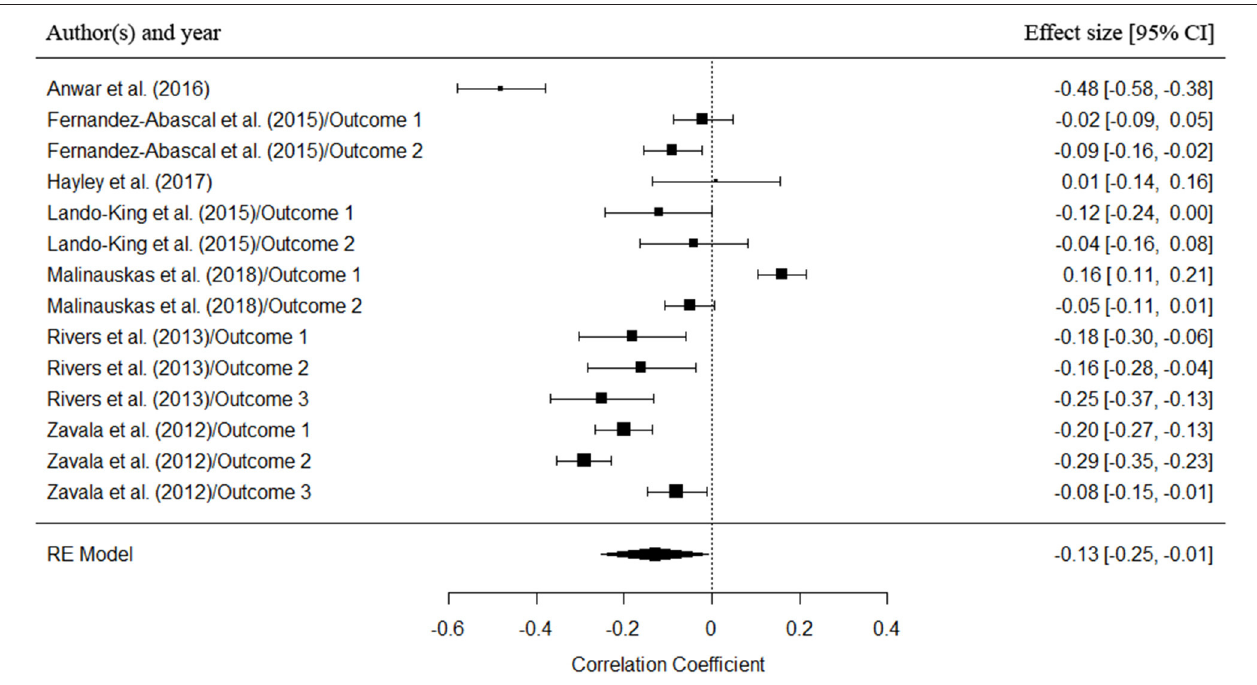
FIGURE 2 | Forest plot displaying the individual and pooled effect sizes (and 95% confidence intervals) of the studies relating EI and health-related risk behaviors included in the meta-analysis. Box sizes represent the weight of each study in the